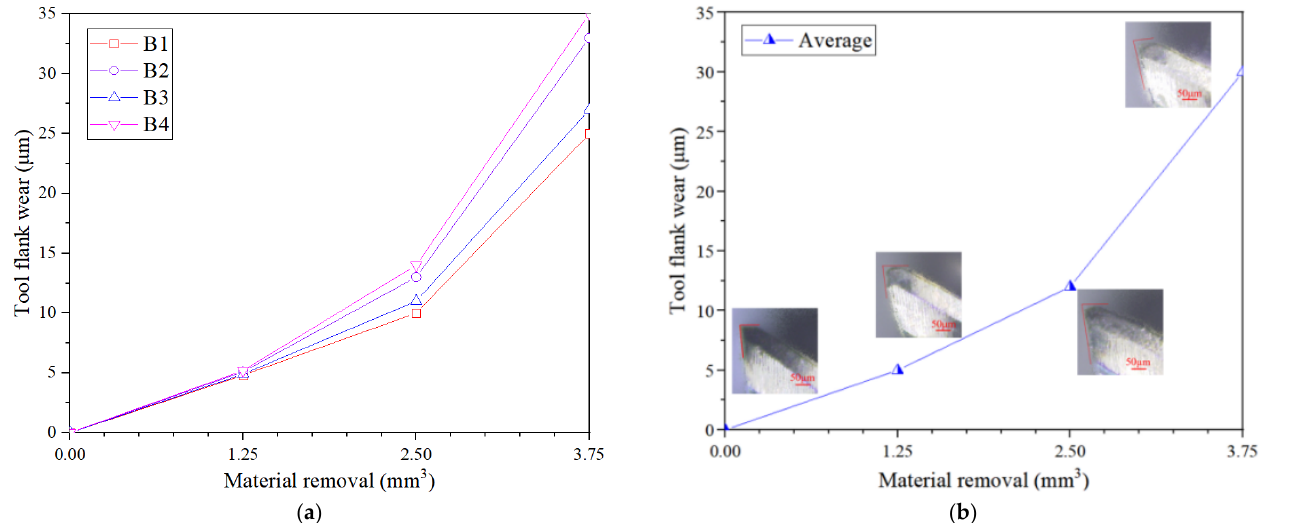
Figure 12. Effect of material removal volume on tool flank wear in micro milling Ti-6Al-4V. ( a ) Tool flank wear of different cutting edges; ( b ) the average amount of tool flank wear.